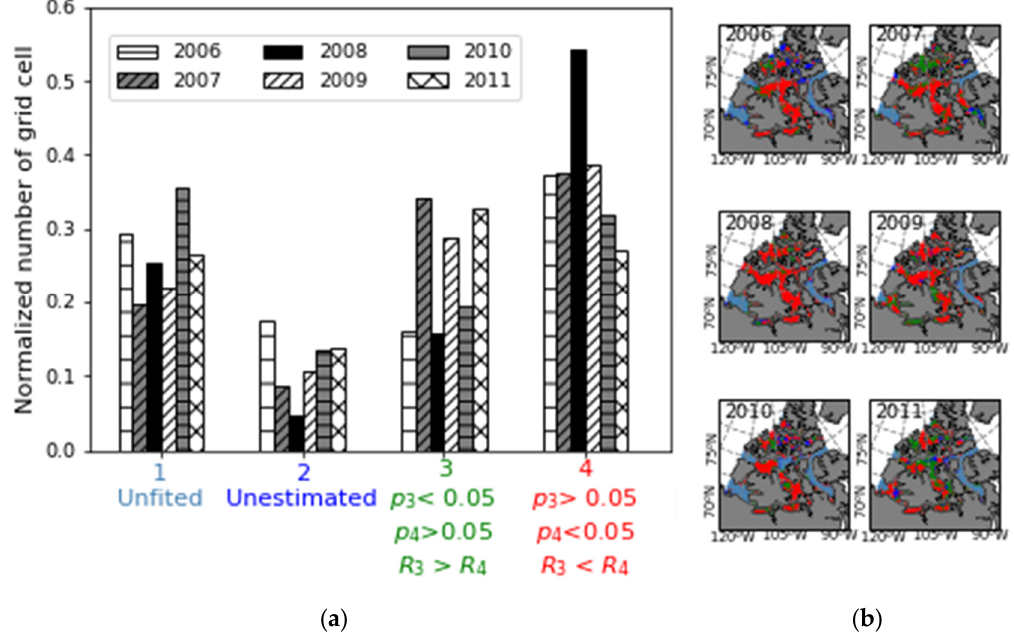
Figure 5. (a) Histogram and (b) spatial distributions for each case in the Canadian Arctic Archipelago (CAA), from 2006 to 2011.